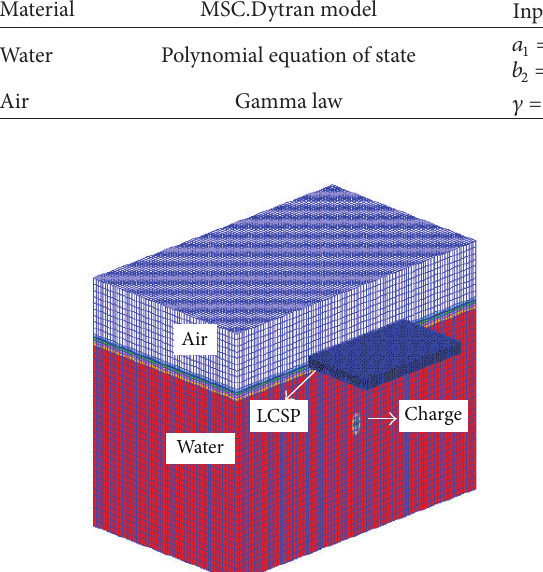
Figure 6: Euler domain mesh.